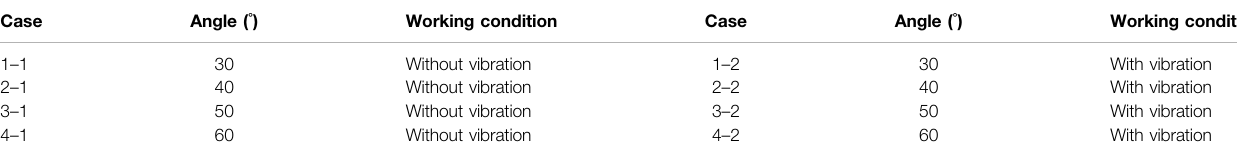
TABLE 3 | Table of SPH simulating cases of conceptual slope.